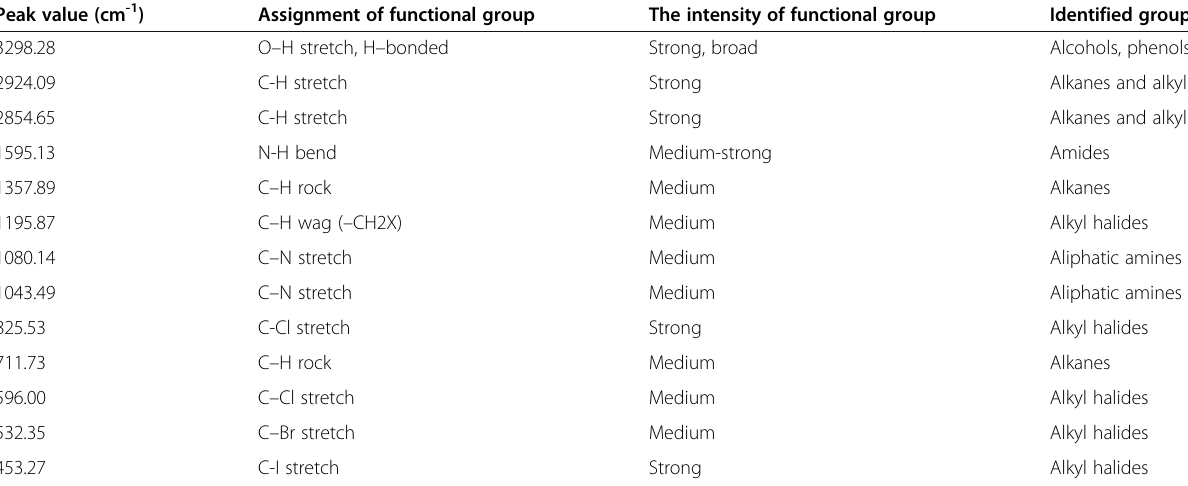
Table 6 FT-IR peak values interpretation of bioactive F-D as follows Peak value (cm -1 ) Assignment of functional